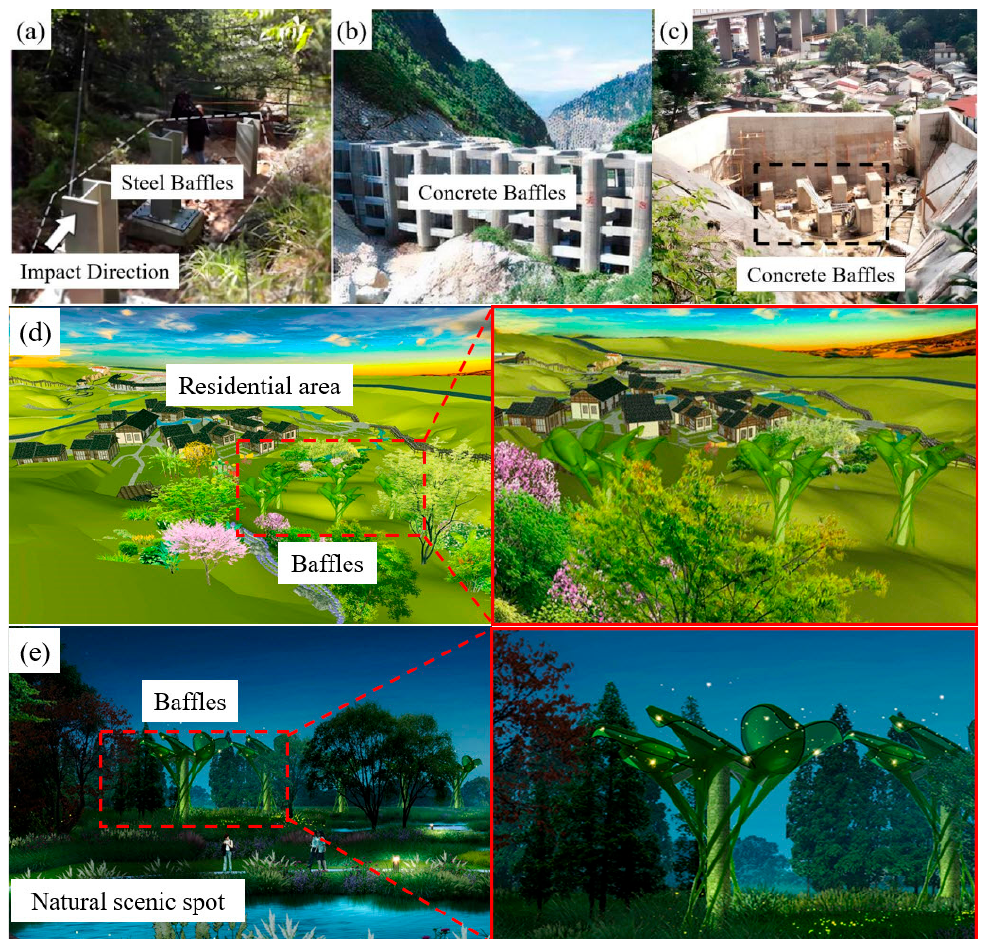
Figure 22. A comparison of traditional baffle group application examples and design renderings, ( a )